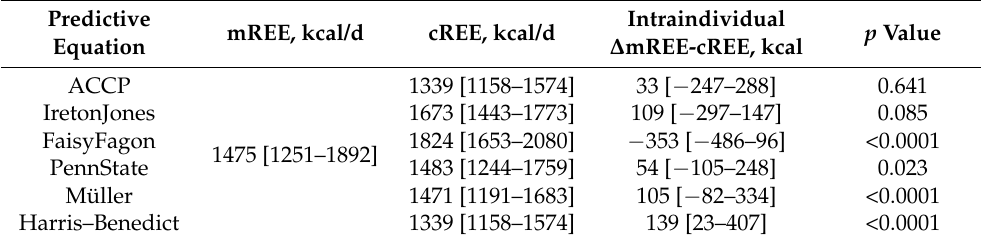
Table 2. Calculated and measured median resting energy expenditure in the critically ill patient cohort. Significance of ∆ mREE-cREE (kcal/d) was assessed using Wilcoxon test; differences are given for the whole cohort as the mean of the intraindividual differences between measured and estimated resting energy expenditure. Abbreviations: ACCP: REE calculated from Cerra et al.; FaisyFagon: REE calculated from Faisy et al.; HarrisBenedict: REE calculated from Harris and Benedict; IretonJones: REE calculated from IretonJones et al.; Müller: REE calculated from Müller et al.; kcal: kilocalories; d: day; ∆ mREE-cREE (kcal/d): difference between measured and calculated resting energy expenditure expressed in kilocalories per day; IQR: interquartile